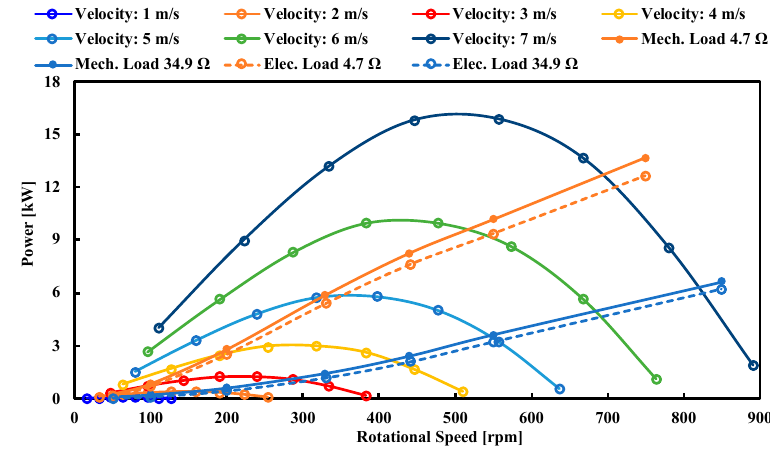
Figure 18. Measured Electrical load output power and rotational speed of the full-scale generator in various load resistance: R 3ph = 4.7–34.9 Ω .